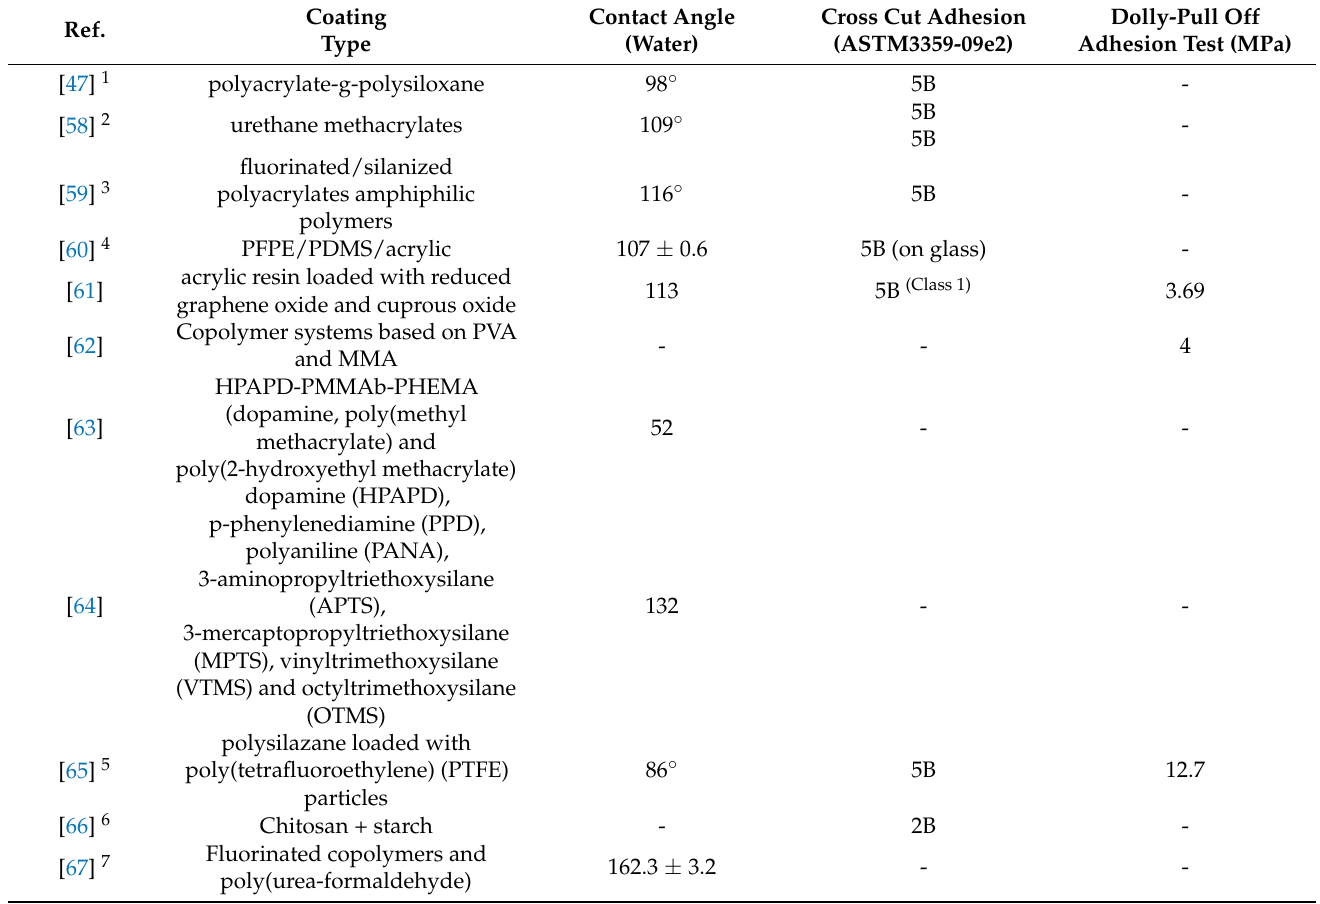
Table 4. Contact angle and mechanical characterization of other coating systems.